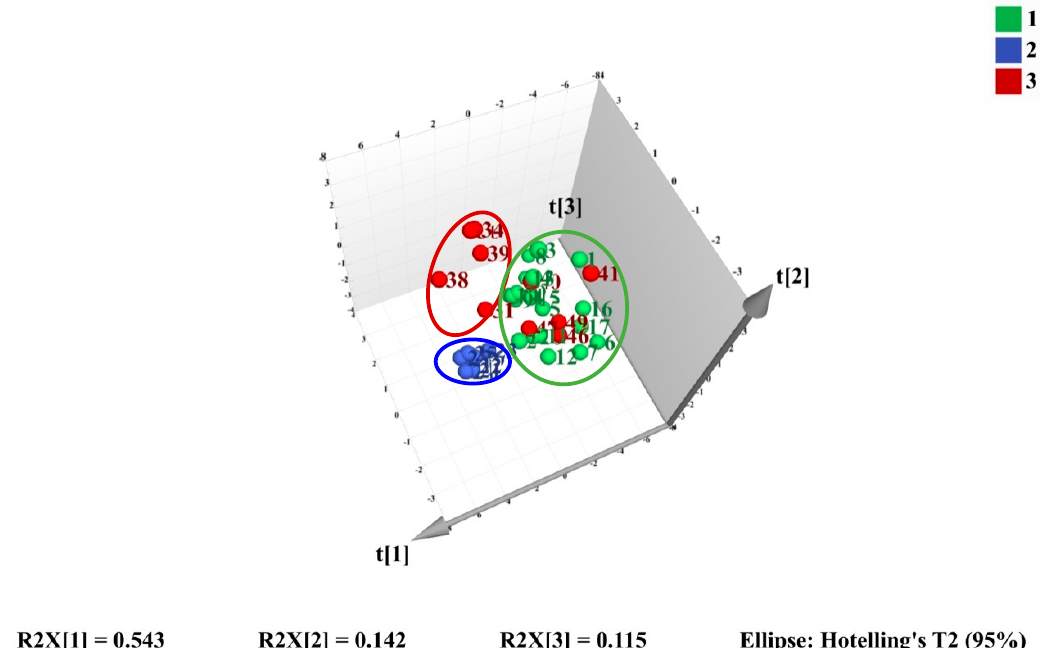
Figure 4. 3D score plot of PCA on the first three PCs for training set samples.